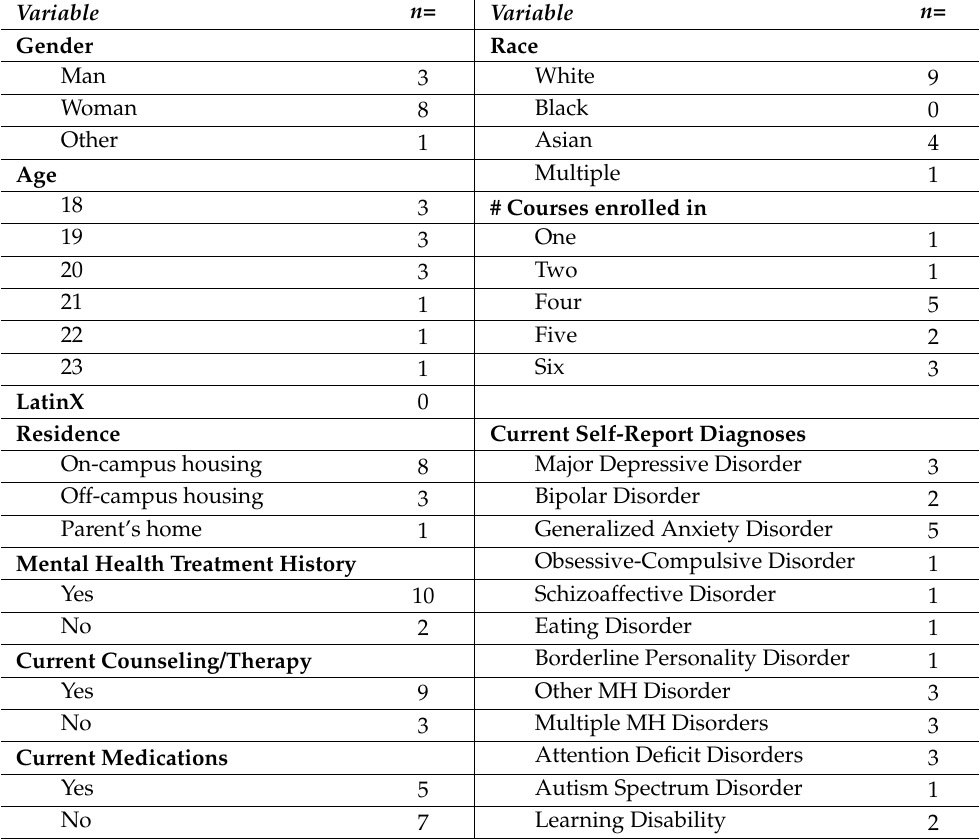
Table 1. Baseline characteristics of study participants (N =